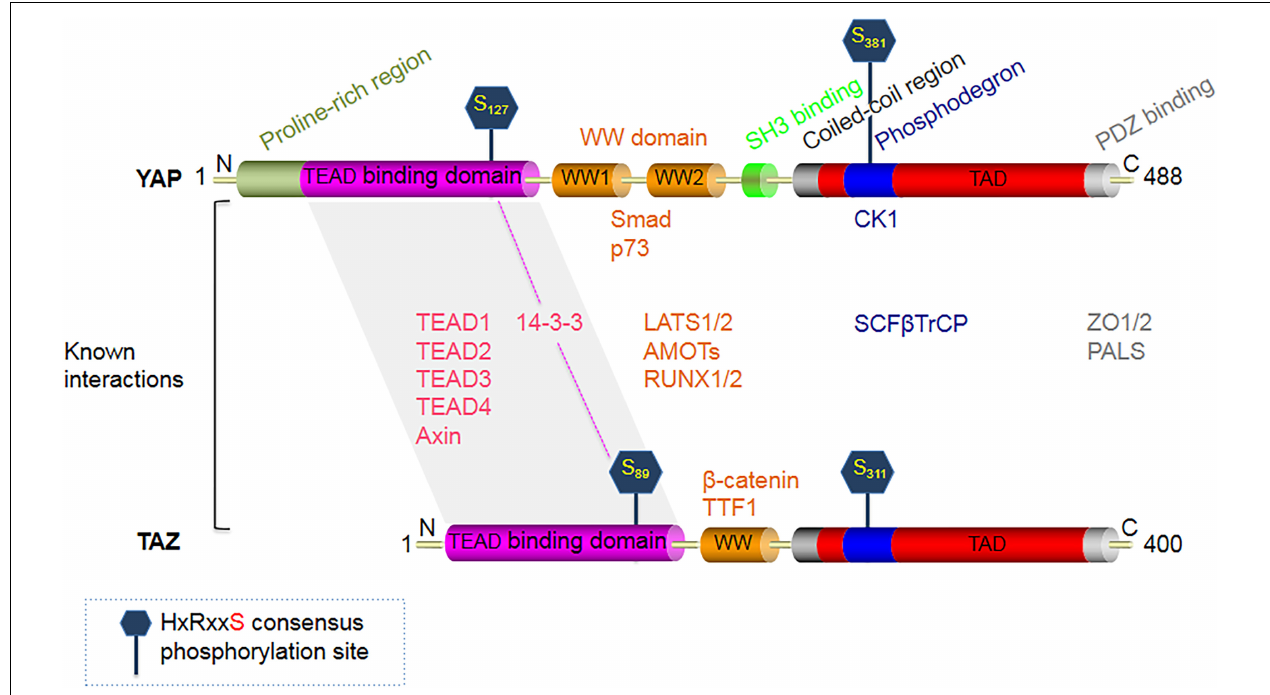
FIGURE 1 | Structural domains of the Hippo signaling pathway effector protein YAP (65 KDa), and its smaller paralog TAZ (43 KDa). YAP is constituted of an N-terminal proline-rich region, followed by a TEAD-binding region, two WW domains, a Src homology domain 3 (SH3) binding motif, a coiled-coil domain (CC), a phosphodegron motif, a transcription activation domain (TAD), and finally a C-terminal PDZ-binding motif. TAZ is similar in structure to YAP, except that it lacks 3 domains present in YAP - the N-terminal proline-rich region, one WW domain, and the SH3 binding motif. The major phosphorylation target sites of LATS1/2 on YAP are S127 and S381, while the corresponding target phosphorylation sites on TAZ are S89 and S311. Upon phosphorylation, YAP/TAZ binds to 14-3-3, which inhibits their translocation into the cell